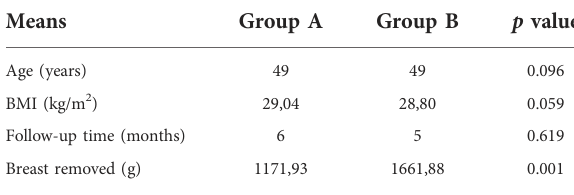
TABLE 2 Group means comparison for age, BMI, follow-up time and total breast removed. 0.05 was considered for statistical signi fi cance.